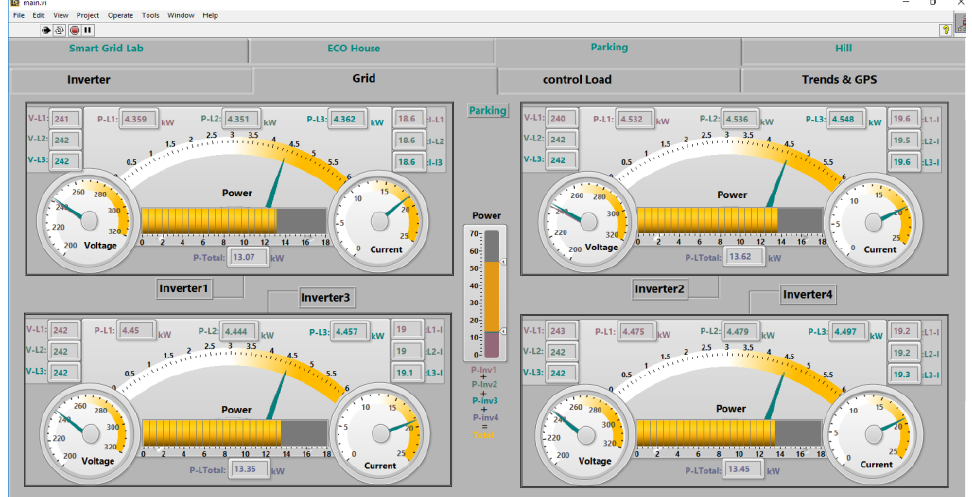
Figure 18. LabVIEW v isualization of inverter’s AC -side quantities.